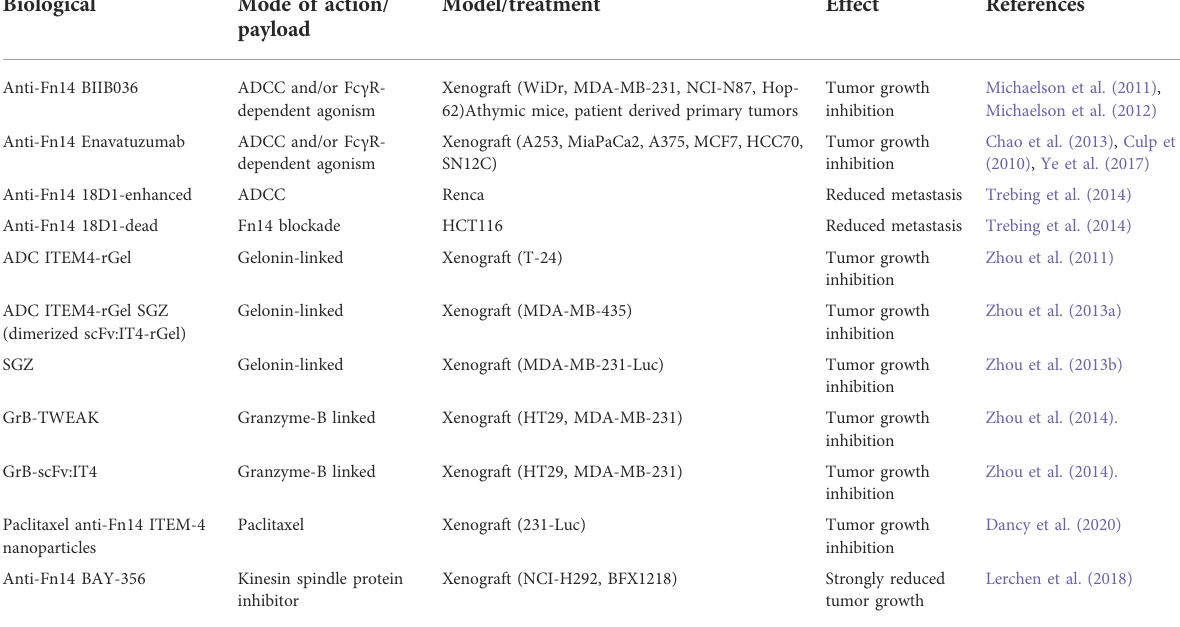
TABLE 3 Anti-tumor activity of Fn14-targeting